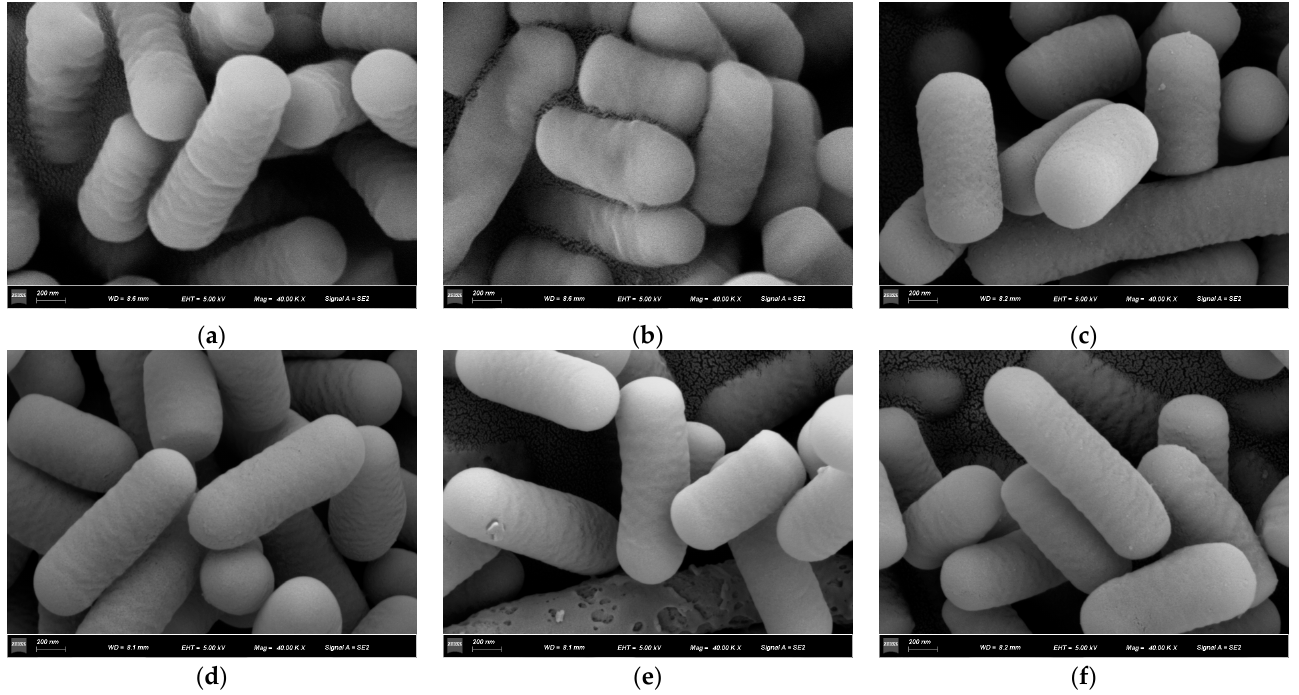
Figure 5. The SEM image of the strains (40,000 magnification), ( a , b )—strain 121 before and after binding BaP, ( c )—strain 121 combined with BSA binding BaP, ( d , e )—strain ML32 before and after binding BaP, ( f )—strain ML32 combined with BSA binding BaP.